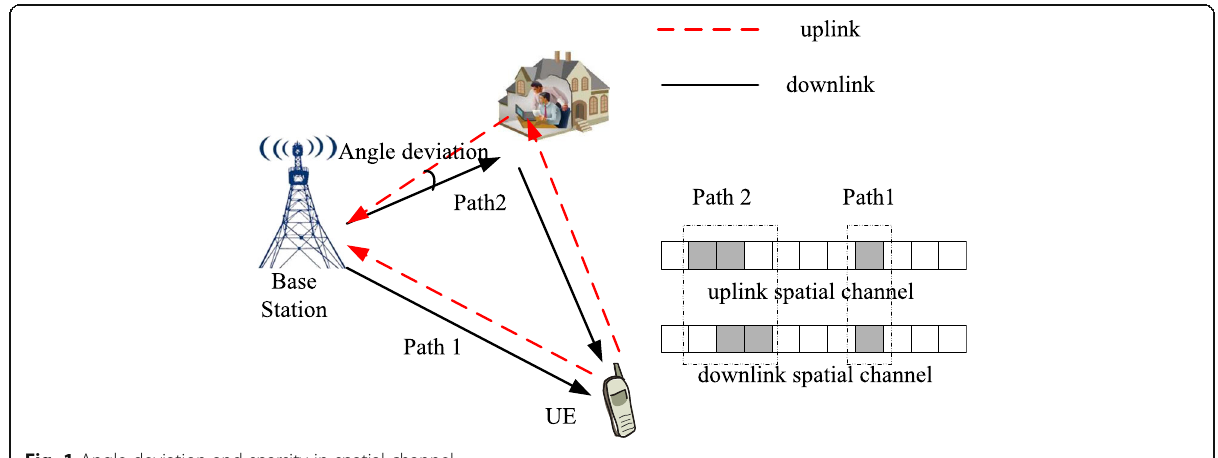
Fig. 1 Angle deviation and sparsity in spatial channel